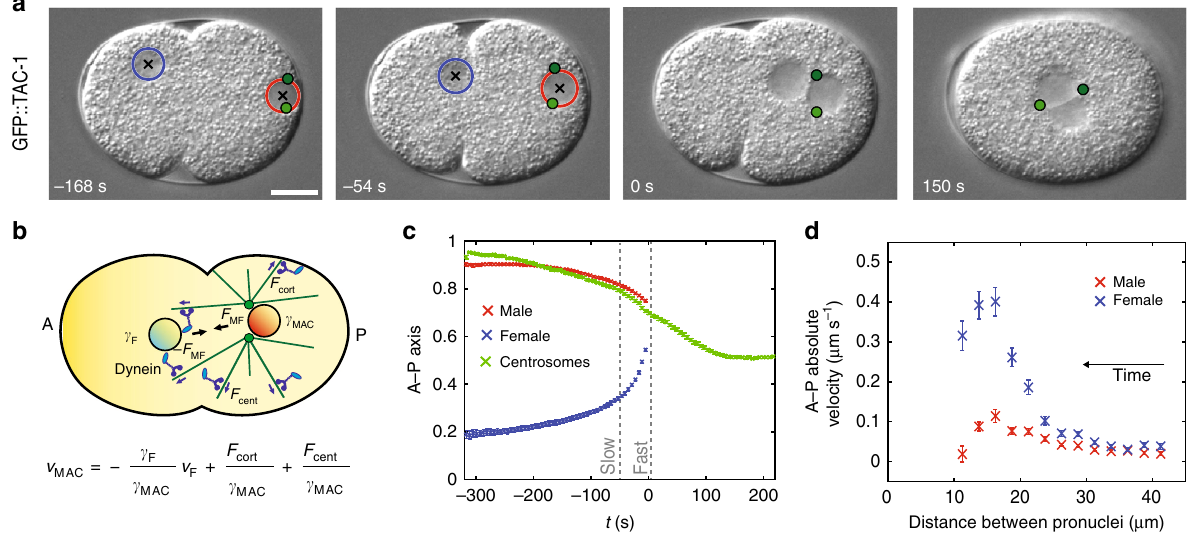
Fig. 1 3D time-lapse microscopy of pronuclear migration and centration in the one-cell C. elegans embryo. a Pronuclei and centrosomes monitored with 3D time-lapse DIC and GFP fl uorescence microscopy in embryos expressing GFP::TAC-1. Here and in other fi gures, representative DIC images are shown; centrosomes (green dots — z-projections), the female pronucleus (blue circle), and the male pronucleus (red circle) are represented; black crosses: pronuclei centers — z-projections. 0 s: pronuclear meeting unless speci fi ed otherwise; scale bars: 10 μ m. b Schematics of forces acting on pronuclei during their migration. Here and in other fi gures, embryos are schematized with the female and male pronuclei (blue and red disks, respectively), centrosomes (green dots), microtubules (green lines), dynein motors (blue), and dynein anchors (light blue ellipses); arrows represent exerted forces. Anterior (A) and posterior (P) sides are indicated. c Average pronuclear and centrosome midpoint positions along the A – P axis as a function of time ( n = 33, with S.E.M.). Here and thereafter, position on the A – P axis is represented in normalized coordinates (0: anterior; 1: posterior). d Absolute average pronuclear velocities as a function of the distance separating them, which decreases over time ( n = 33, with S.E.M.). Velocities increase while pronuclei approach each other and then diminish when the male-asters complex and the female pronucleus get closer than ~15 μ m from one another, probably because of steric hindrance effects. F MF force exerted between the male-asters complex and the female pronucleus, F cort force exerted by cortical dynein, F cent centering force, γ F , γ MAC drag coef fi cient of the female pronucleus and male-asters complex,